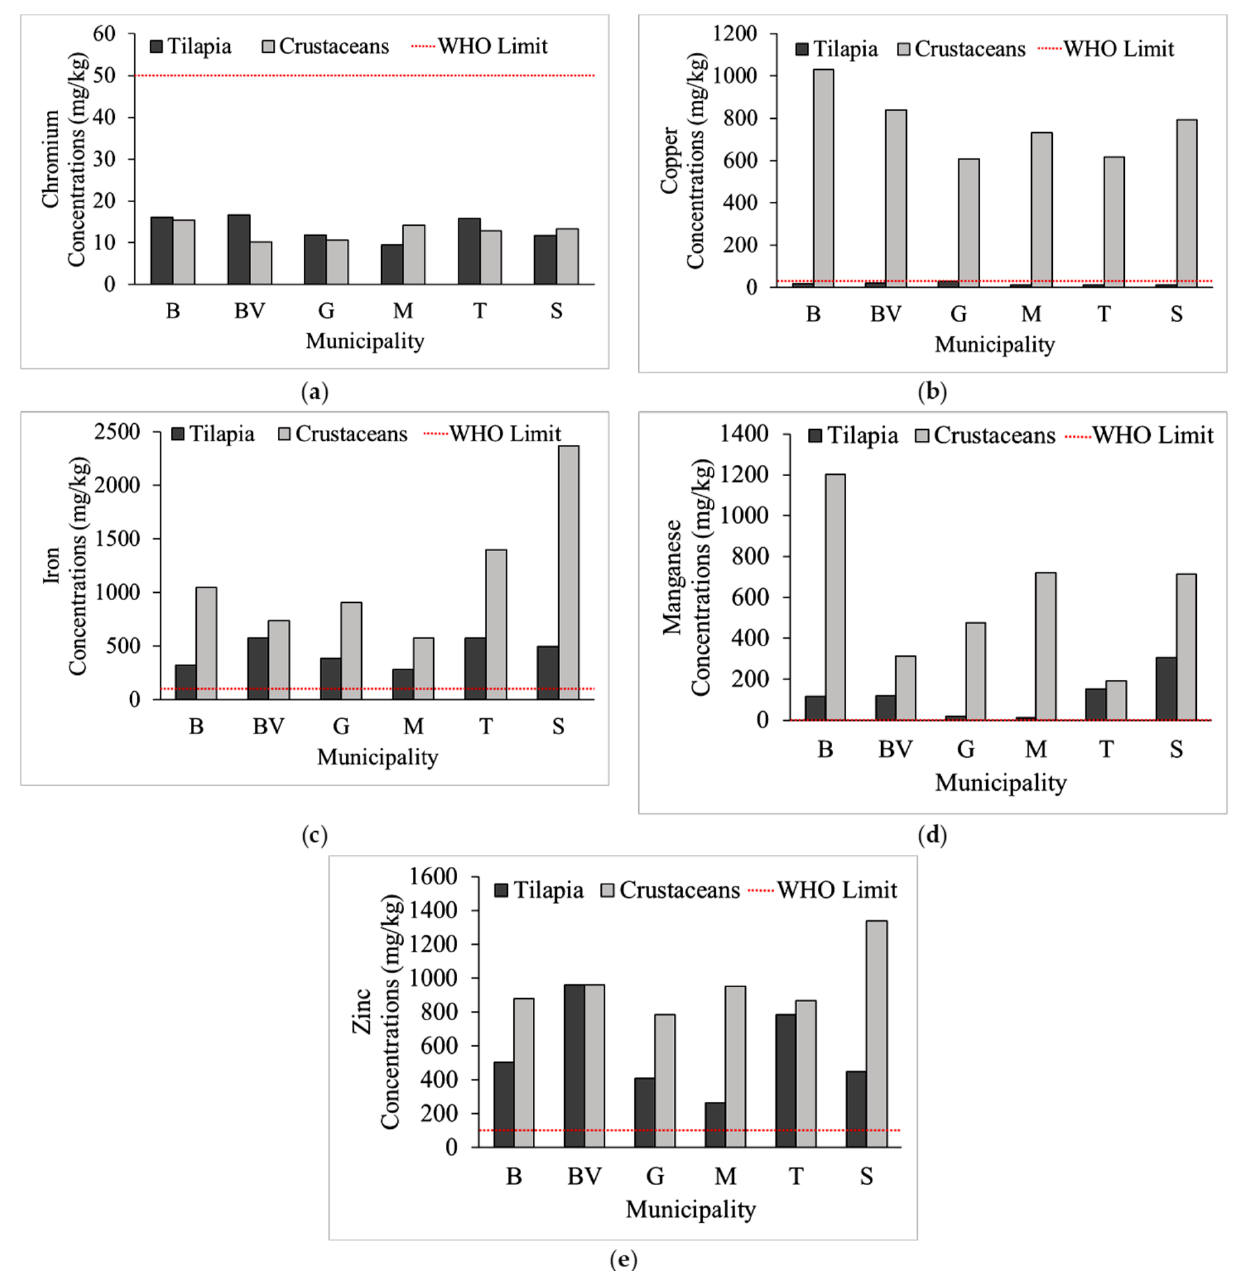
Figure 3. The concentrations of tilapia and crustaceans per municipality of the island province. Note: The red horizontal line represents the maximum permissible limit (MPL) set by WHO. The vertical bars are the concentration of metals in tilapia and crustaceans. The concentration of Cr ( a ) in both tilapia and crustaceans was below MPL. The concentration of Cu in crustaceans ( b ) was beyond the WHO MPL However, the Cu concentration in tilapia was below WHO MPL. The Fe concentration ( c ) in both tilapia and crustaceans was beyond MPL in all six municipalities. The Mn concentration ( d ) in both tilapia and crustaceans was beyond WHO MPL. Mn concentration in crustaceans collected from Gasan and Mogpog recorded the lowest concentration among the six municipalities. The municipality of Boac recorded the highest Mn concentration in crustaceans. The Zn concentration ( e ) in both tilapia and crustaceans was beyond the MPL in all six municipalities. Sta. Cruz municipality recorded the highest concentration in the island province for iron and zinc. Boac municipality recorded the highest concentration for copper and